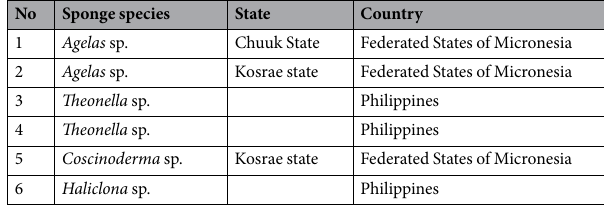
Table 1. Marine sponge extracts used in this